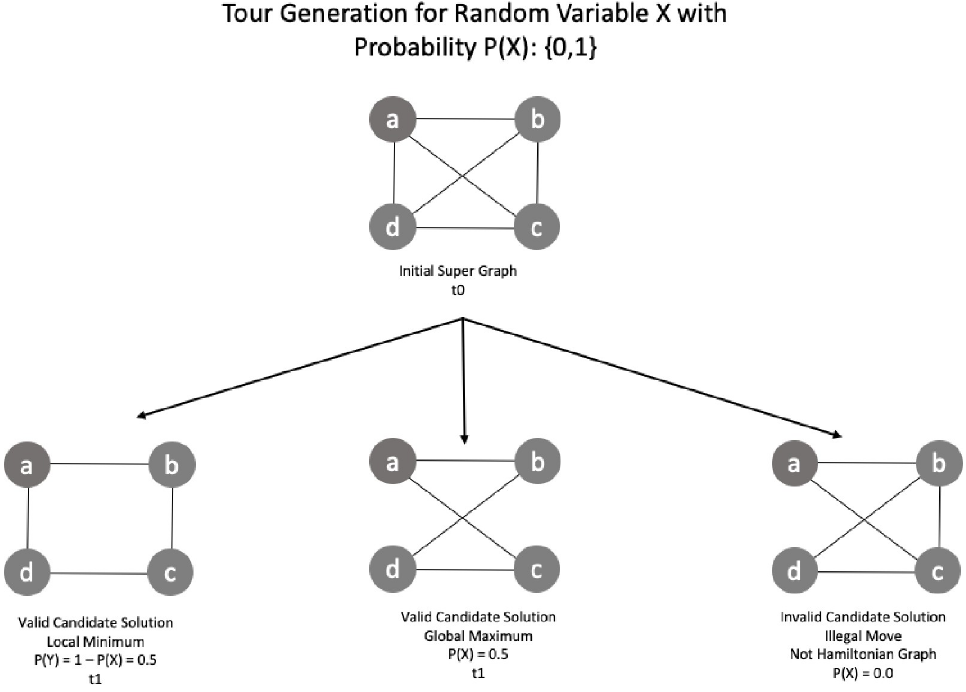
Fig 27. Candidate solution production and path decision.